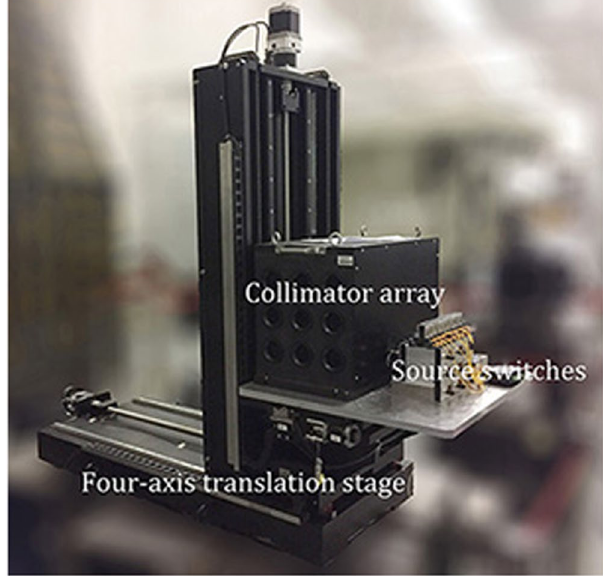
Figure 7. Four-axis translation stage loaded with a collimator array for carrying out bi-dimensional scans.